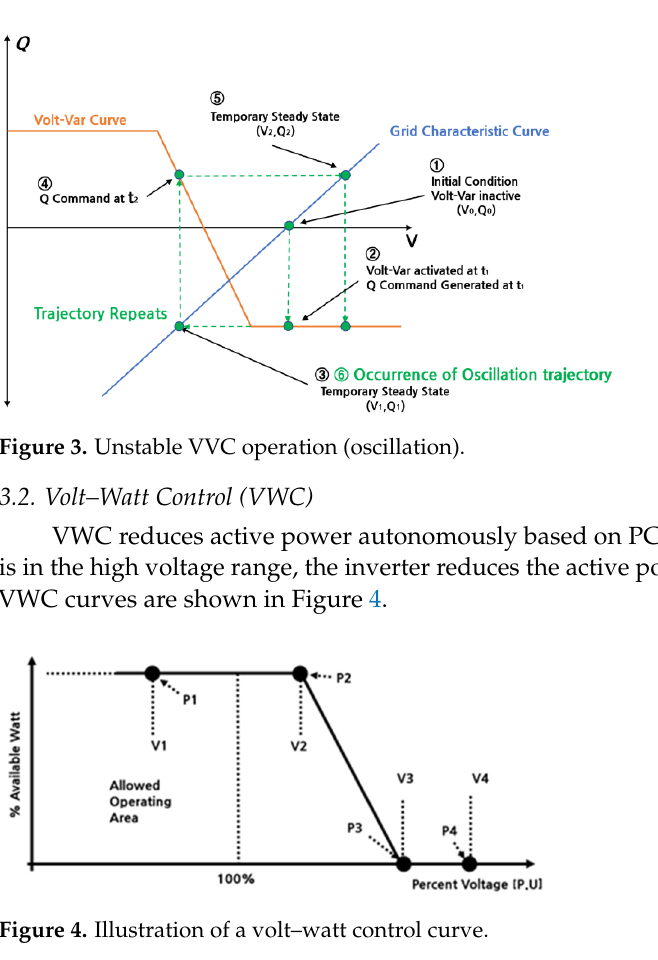
Figure 4. Illustration of a volt–watt control curve.